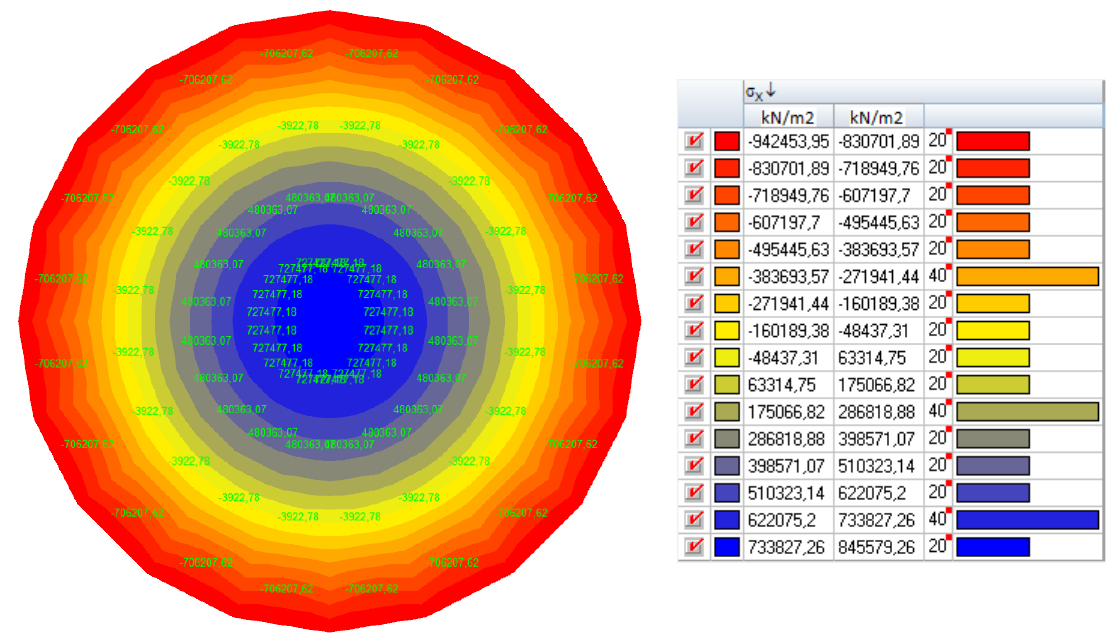
Figure 11. Graphical analysis of stress fields in membranes.